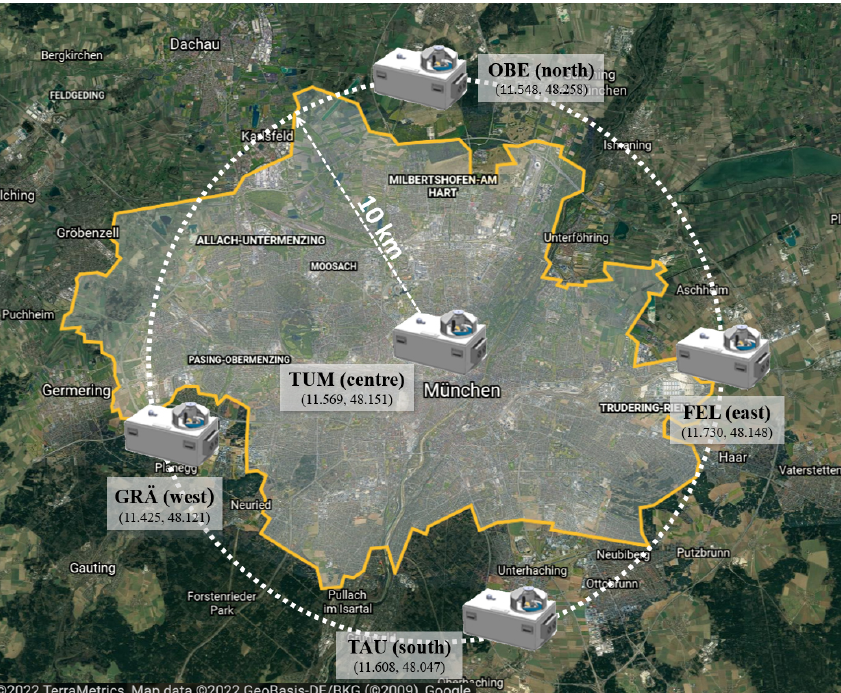
Figure 1. Locations of EM27/SUN spectrometers in Munich. The center site is located on the roof of the TUM building in Munich. The other spectrometers are distributed around Munich in each compass